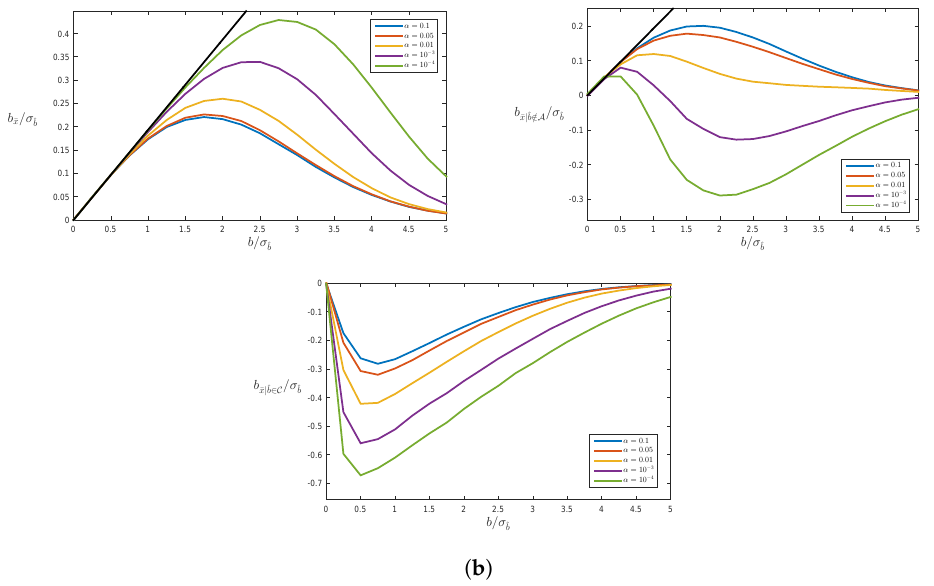
Figure 8. Estimation-testing bias in up-component of GPS+Galileo model (31) due to pseudorange = 1.36 m ) or in Galileo PRN 64 (case ( b ), σ bias in GPS PRN 1 (case ( a ), σ ˆ b unconditional bias b ¯ x , correct detection bias b ¯ x | CD , and correct identification bias b ¯ x | CI , with C the correct identification area for ˆ b . The black straight lines correspond with the ’no-testing’ bias b ˆ x